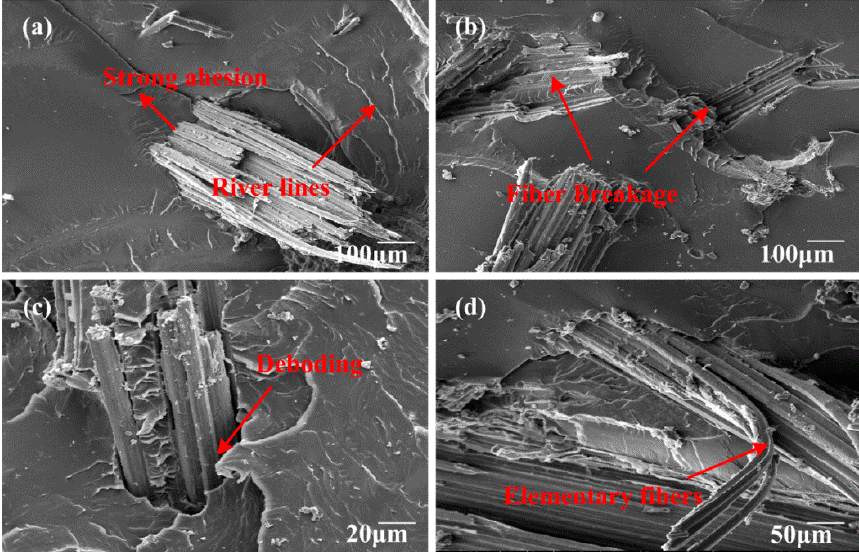
Figure 17. SEM images of composites with fiber length of 5 mm. Figure 18. SEM images of composites with fiber length of 10 Figure 18. SEM images of composites with fiber length of 10 mm.